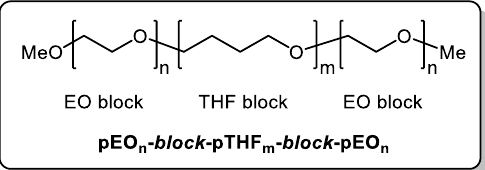
Figure 4. The chemical structure of pEO n - block -pTHF m - block -pEO m (CP1 and CP2) triblock copolymer. For CP1 n = 15, n = 33; CP2 n = 11, m = 9.